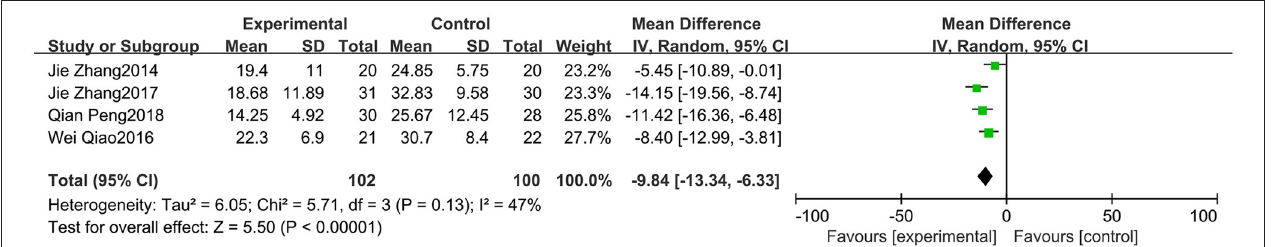
FIGURE 3 | Forest plot of decrease of systolic blood pressure (SBP).